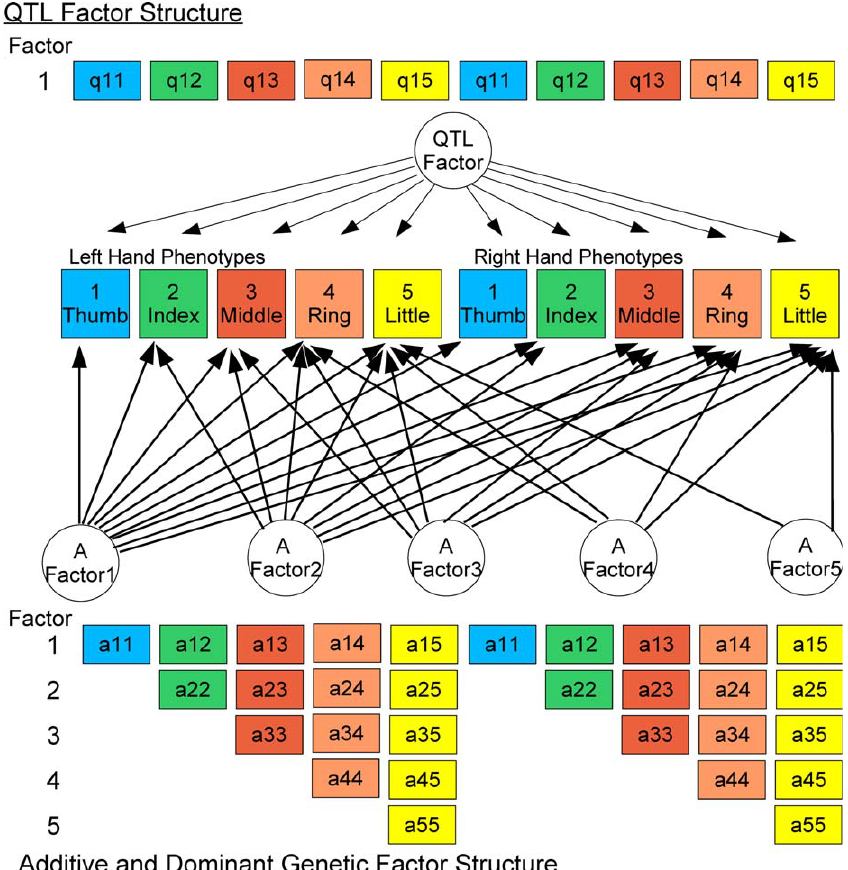
Figure 4. Schematic Representation of the Additive and Dominant Genetic and QTL Factor Structures The unique environmental factors structure (not shown) contained ten variables (using a full Cholesky decomposition). In the diagram below, color coding is used to indicate which parameters load on each digit, while horizontal arrays are used to indicate factor structure (e.g., the first additive genetic factor loads on all ten phenotypes, while factor 5 loads only on the little finger).